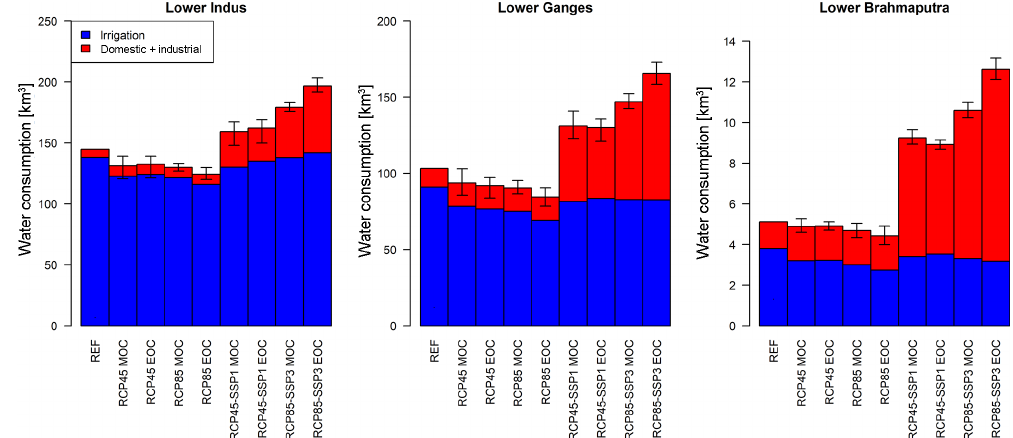
Figure 6. Projected changes in the annual blue water consumption for irrigated croplands and other users (i.e. domestic + industrial) for RCP4.5, RCP8.5, RCP4.5-SSP1, and RCP8.5-SSP3. The projected changes are given for the mid-21st century and end of the 21st century (MOC and EOC) and represent the ensemble mean. The error bars denote the range of the ensemble